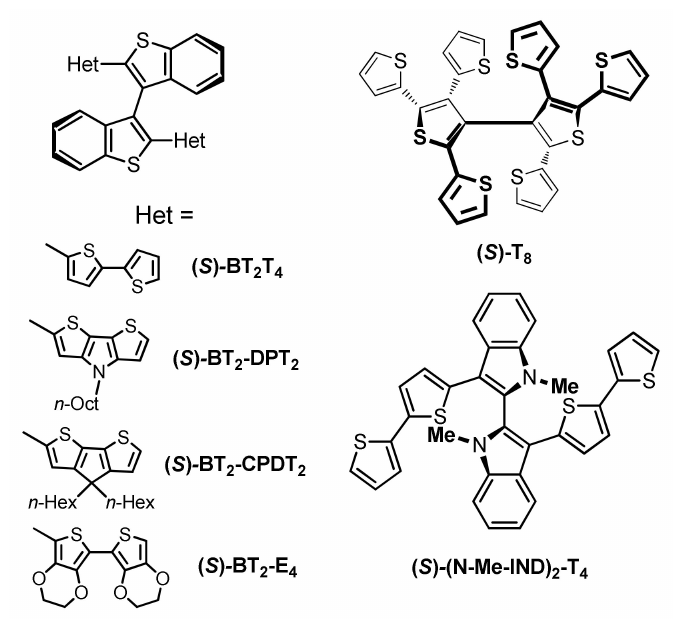
Figure 1. The three families of inherently chiral monomers.